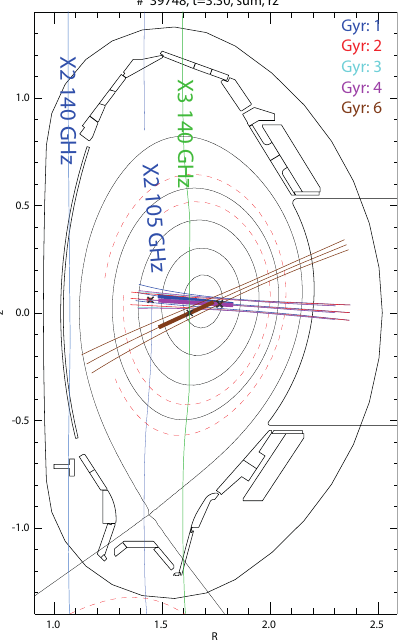
Figure 5. Beam propagation, cold resonances and regions of EC power deposition as calculated by TORBEAM for #39748 at 3.3 s (i.e. beam 8 o ff ), which is the pre-heating phase of the second sweep. The phase is similar as in #39747 except that beam 8 is o ff and ECE data are available. The T e profiles used for the TORBEAM calculation are based on the LFS ECE channels (see discussion in section 2.2.